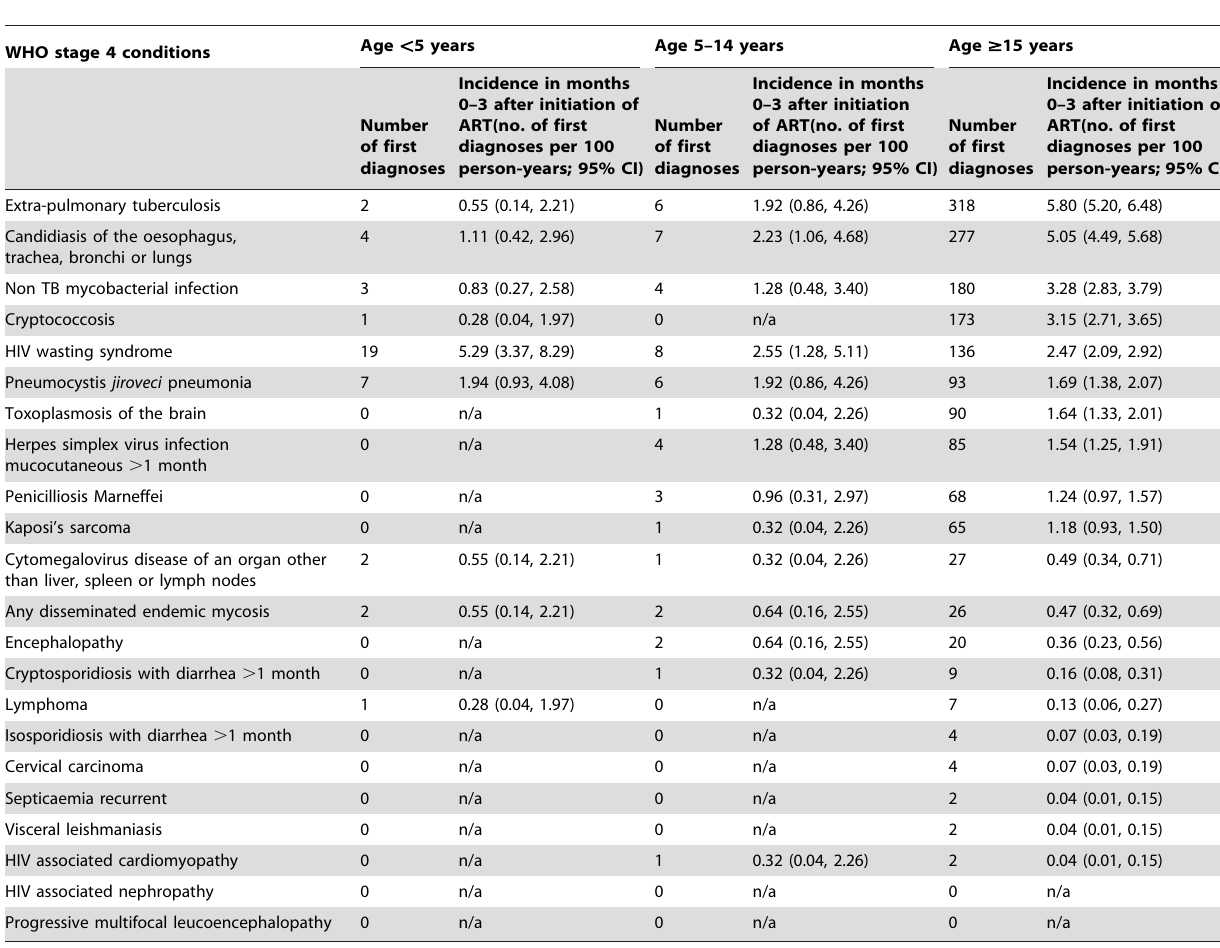
Table 7. Disease specific Incidence of WHO stage 4 conditions in months 0–3 following ART initiation by